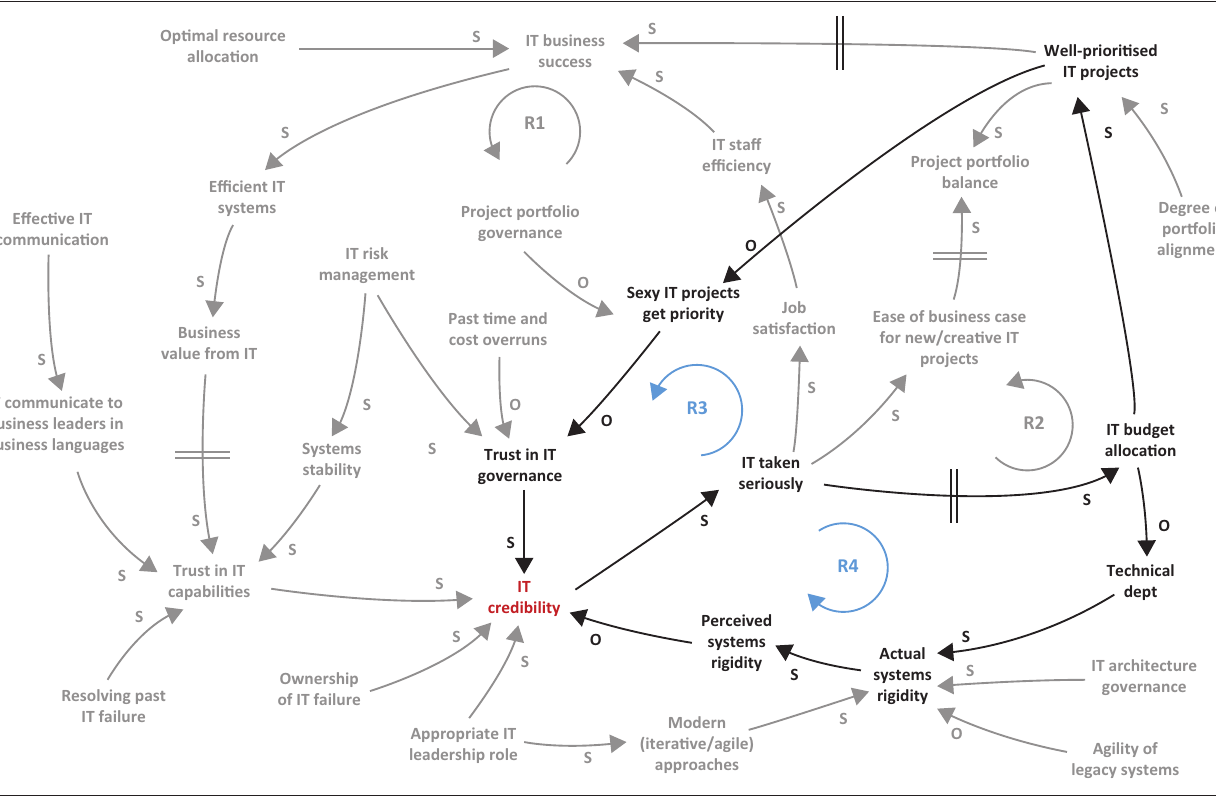
FIGURE 5: Information technology credibility reinforcing feedback loops R3 and R4.